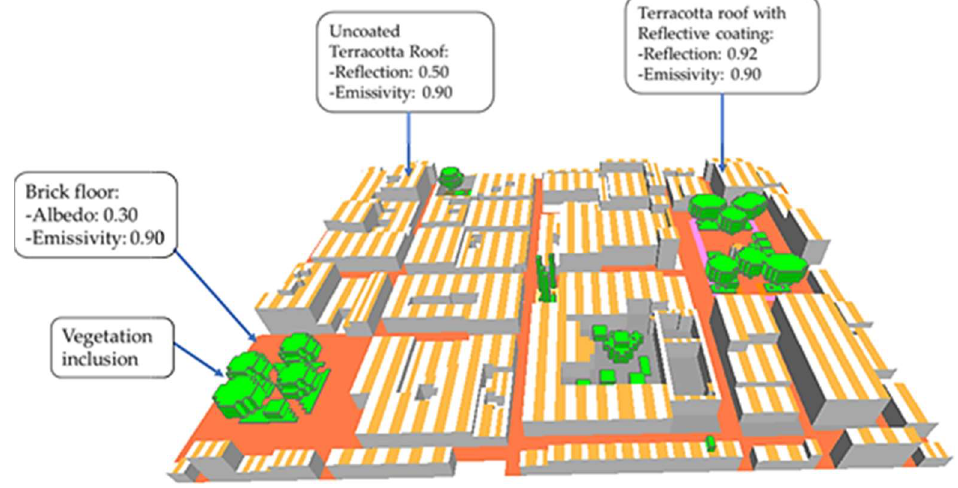
Figure 8. Schematic of case 1 developed in Envi-met.